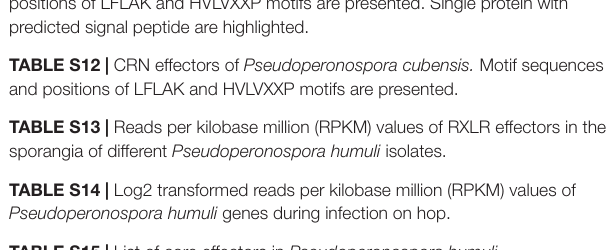
TABLE S10 | Average number of motifs in permuted sequences and secretome in Pseudoperonospora humuli and Pseudoperonospora cubensis . TABLE S11 | CRN effectors of Pseudoperonospora humuli. Motif sequences and positions of LFLAK and HVLVXXP motifs are presented. Single protein with predicted signal peptide are highlighted.